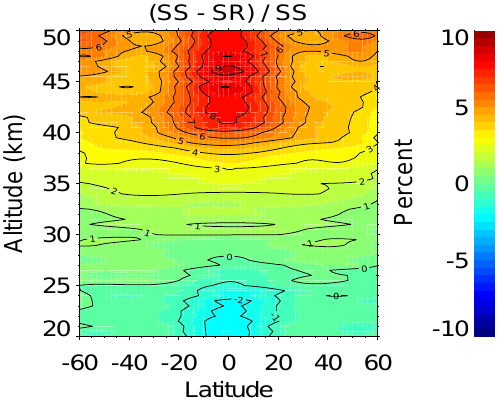
Figure 12. Results of the local event type piecewise term from the STS regression plotted as the percent difference between sunrise and sunset events. Figure 13. Biases for each monthly zonal mean for the MZM method compared to the STS method computed as (MZM-STS)/STS*100. The MZM method does not differentiate between event types so it does not have different values for each type. White areas show regions where data do not exist or where one or both regression methods failed to converge to a solution.